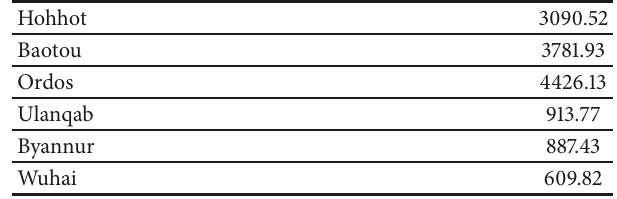
Table 3: GDP of each city in 2015(billion